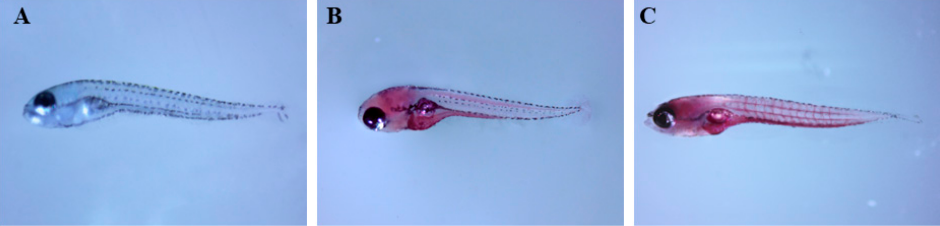
Figure 3. The results of Oil Red O staining after modeling. Note: The zebrafish in the blank control group ( A ) and in the high-fat group were stained for 3 h ( B ) and overnight ( C ). Hypolipidemia: All other things being equal, the feedback of different objects at the same light intensity is different (i.e., the transmitted light index is different), and this value can be calculated from the grayscale value. The darker the target substance is, the less light will be transmitted, representing a higher optical density index. Therefore, the opti- cal density value can be used to measure the content of a component in a tissue or cell.